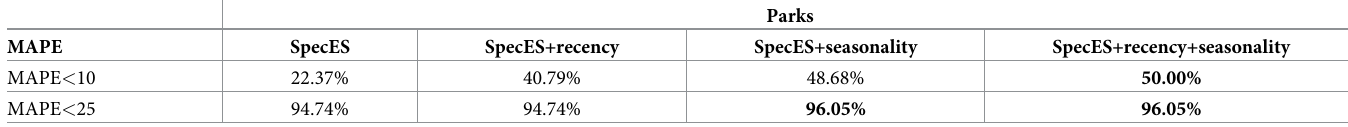
Table 7. SpecES prediction results augmented with the other two tourism requirements—Seasonality and/or recency trained for each of the 76 national parks in U. S. (outdoors). The best prediction models are in bold